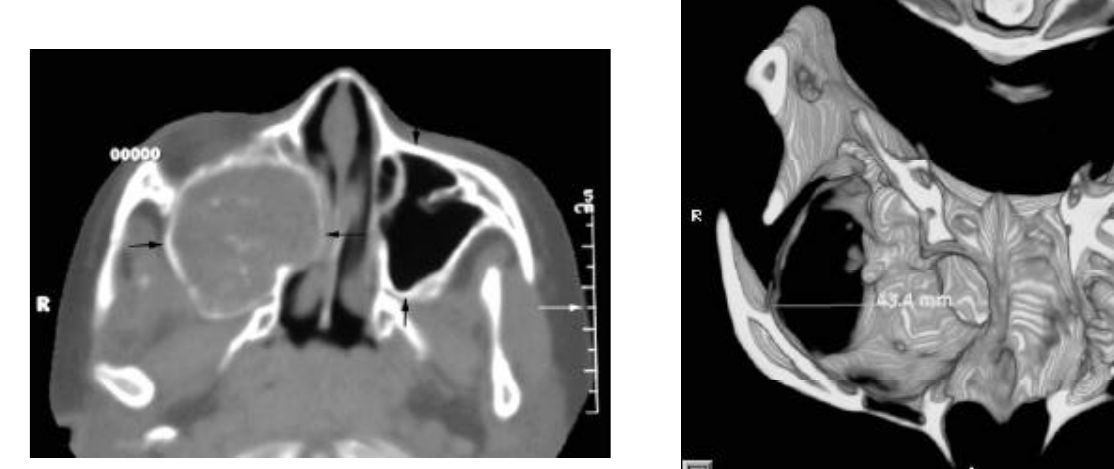
FIGURE 1- 2D-CT axial view is demonstrating the largest diameter delimitation of maxillary sinuses (arrows). The scale, which was used to perform the measurements, is also shown on the right side of the figure (open arrow)